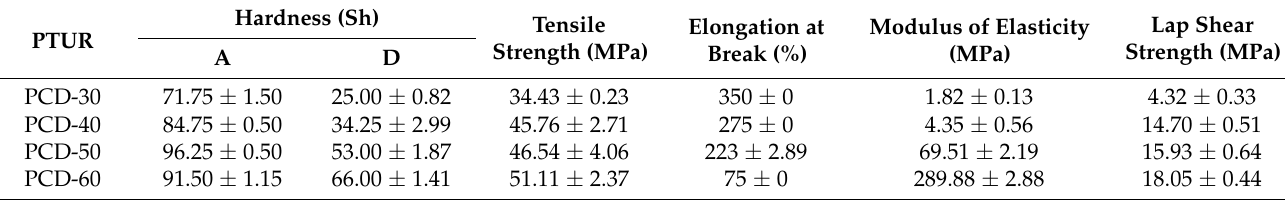
Table 7. Hardness and mechanical properties of